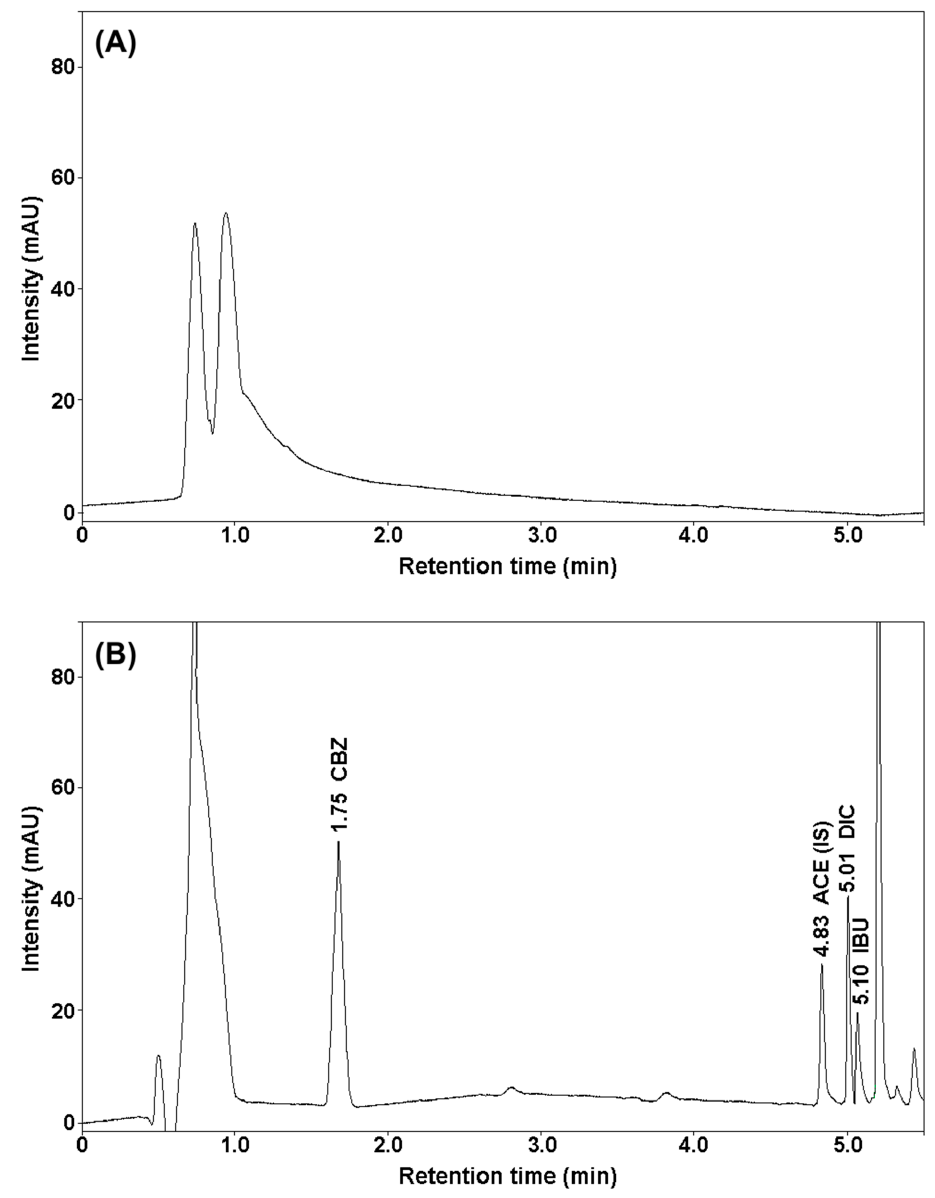
Figure 5. Chromatograms of water sample extracts: ( A ) blank sample, ( B ) samples of water spiked with drugs obtained after Speedisk solid-phase extraction.